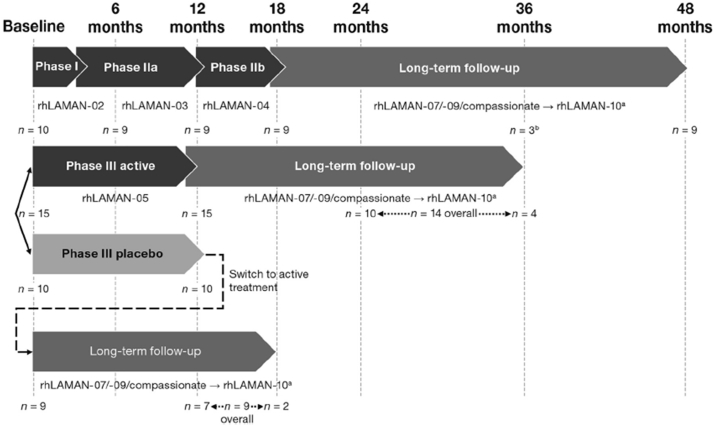
Numbers of patients and contributing studies to integrated analysis.